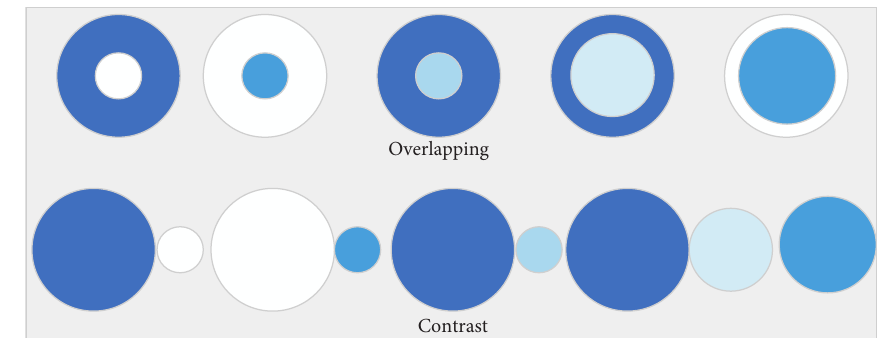
Figure 2: Algorithm flow chart.